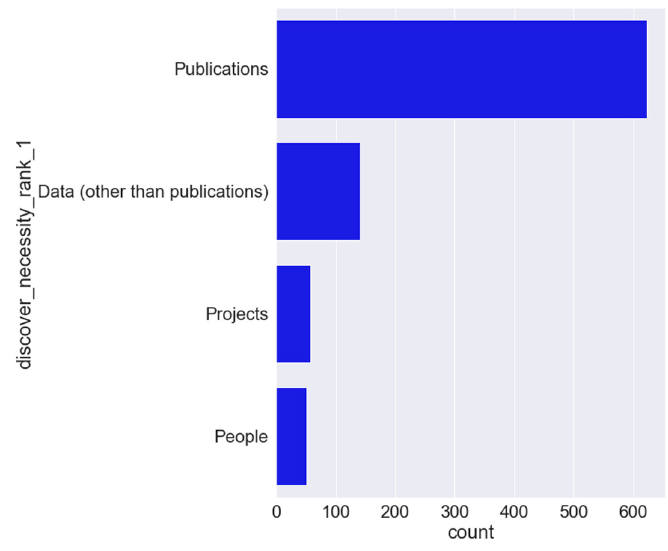
Figure 11. Main discovery need.